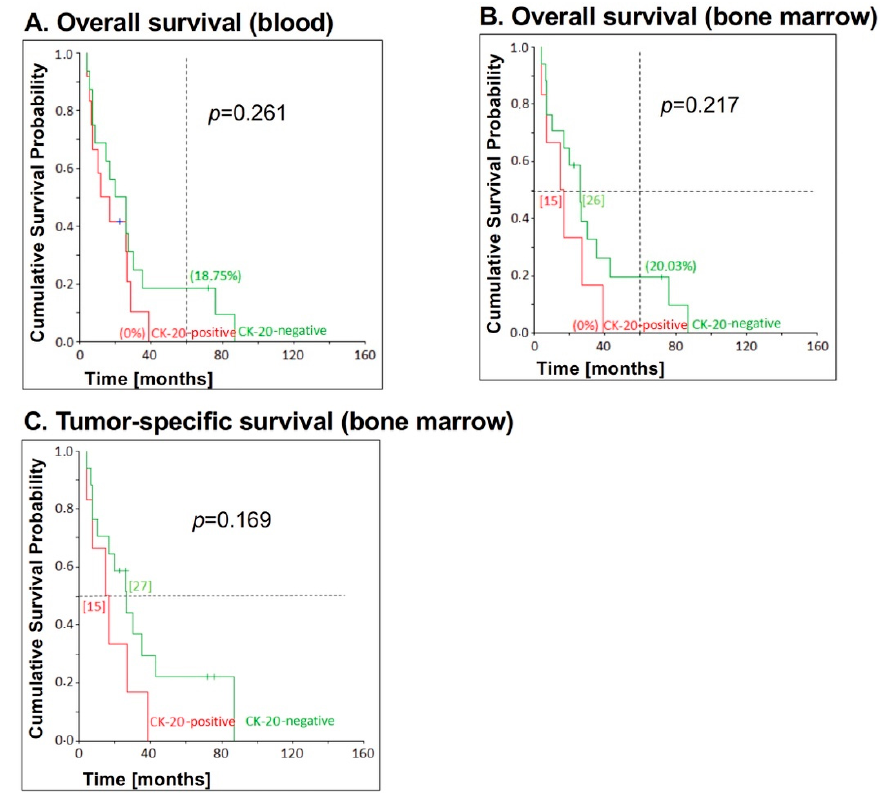
Figure 4. Correlation between CK20 positivity in blood and bone marrow samples, respectively, and survival for patients with esophageal carcinoma UICC stage III and IV. CK20 positivity in ( A ) blood ( n = 12) and ( B , C ) bone marrow ( n = 6) samples of EC patients with advanced tumor stages was assessed by RT-PCR and correlated with ( A ) overall survival in blood samples, ( B ) overall survival und ( C ) tumor-specific survival in bone marrow samples. The p -values for the comparison of the cumulative survival probabilities of the two groups (CK20-positive versus CK20-negative) were calculated using the log-rank test. On the vertical dotted line at 60 months, the percentage 5-year overall survival are shown in brackets. On the horizontal dotted line at the cumulative survival probability of 0.5 is the median survival and is given in months in square brackets.